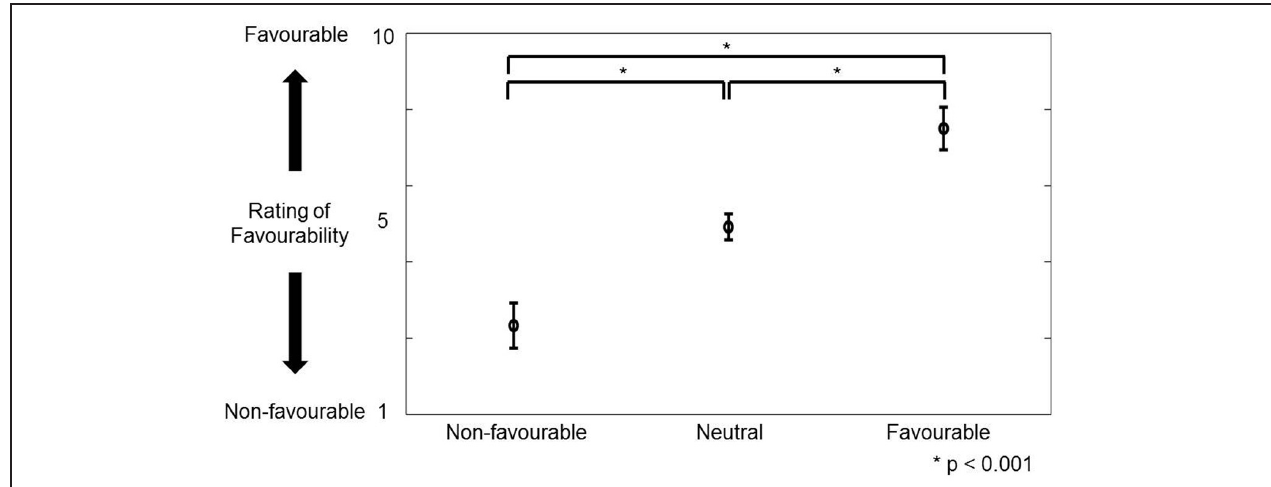
Response time The mean ( ± SD ) response times relative to offset of stimu- lus (seconds) of control subjects and schizophrenia patients for FJT and GDT were the following: FJT-control: 2.41 ± 0.78 s, FJT-patients: 2.01 ± 0.33 s, GDT-control: 2.15 ± 0.78 s, and GDT-patients 1.99 ± 0.05 s. The response times in FJT were sig- nificantly different between control subjects and schizophrenia patients: t ( 34 ) = 2 . 16, p = 0 . 04 < 0.05, whereas there was no sig- nificant difference in the response times to GDT: t ( 34 ) = 0 . 84 p > 0 . 05. Analysis of variance on the response time was per- formed with the factors of Group (control subjects/schizophrenia patients) and Task (FJT/GDT). There was no significant differ- ence between Groups: F ( 1 , 34 ) = 2 . 29, p > 0 . 05, whereas there was a significant Task effect: F ( 1 , 34 ) = 33 . 7, p < 0 . 001. An interaction effect between Group and Task was also